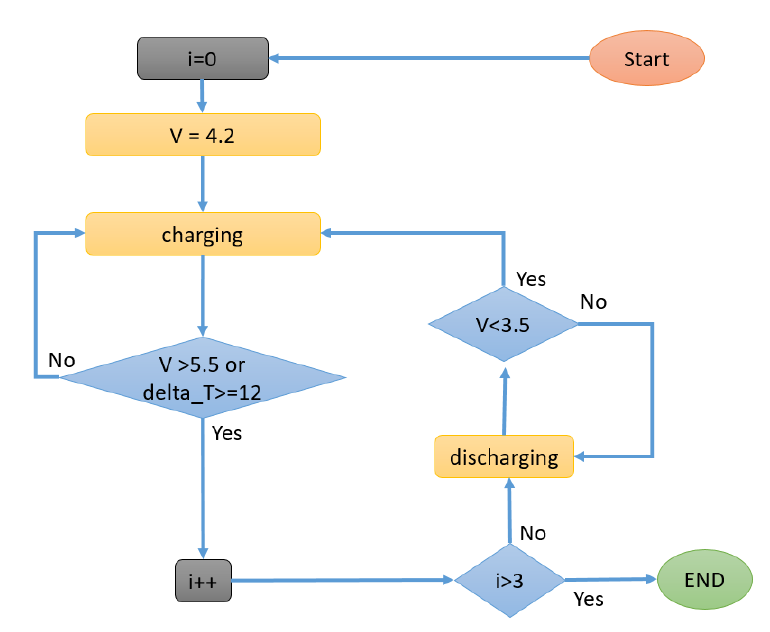
Figure 2. Methodology applied in the OC experiments.